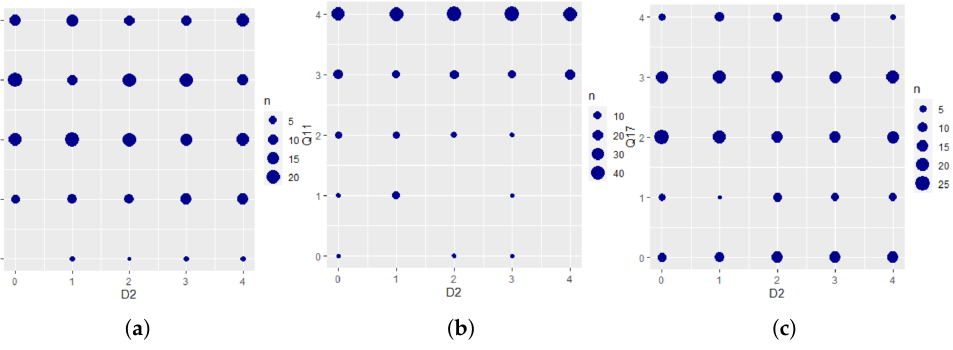
Figure 9. Scatter-plots between the Demographic data related to “D2: Educational Level” and the three selected questions—Q7, Q11 and Q17 (Section 2.2). ( a ) Scatter-plot between D2 and Q7; ( b ) Scatter-plot between D2 and Q11; ( c ) Scatter-plot between D2 and Q17. Table 9. Spearman Rank Correlation